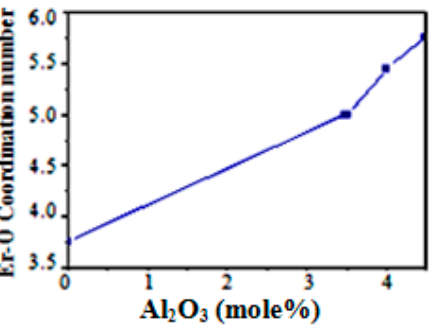
Figure 19. Effect of doping of Al 2 O 3 on Er–O coordination number.